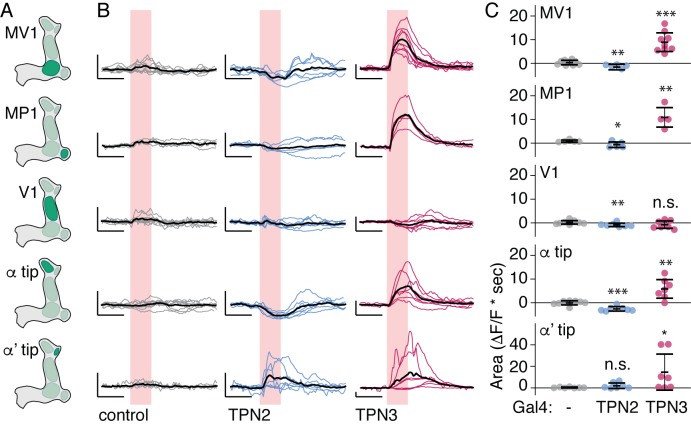
TPNs action on all PPL1 lobes.(A) Schematic specifying PPL1 region focused on for calcium imaging, with CsChrimson activation of TPN2 or TPN3. (B) Average response (black line) and individual traces (gray, blue, and red lines) of PPL1 regions to red light (no Gal4 driver control, TPN2 activation, and TPN3 activation, respectively). Control animals show no responses to red light, while activation of TPN3 generally increases calcium signals in all PPL1, and activation of TPN2 generally results in small but reliable decreases in calcium signal. Pink bar indicates time of laser stimulation. Horizontal scale bar = 5 s. Vertical scale bar = 1 △F/F. (C) Average area under the curve. Compared to no Gal4 controls, TPN2 and TPN3 show significant decreases and increases in calcium signal, respectively. Error bars indicate mean +/-± SEM. n = 9–13. Wilcoxon rank-sum: *p<0.05, **p<0.01, ***p<0.001.